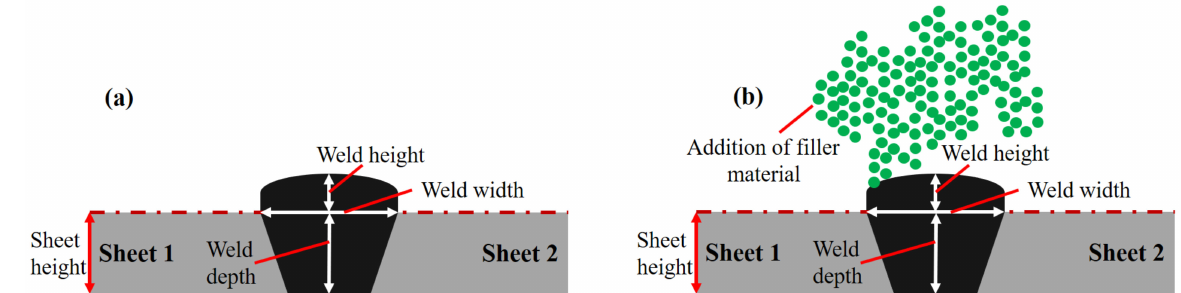
Figure 2. Schematic and nomenclature of weld cross-section: ( a ) without filler and ( b ) with filler